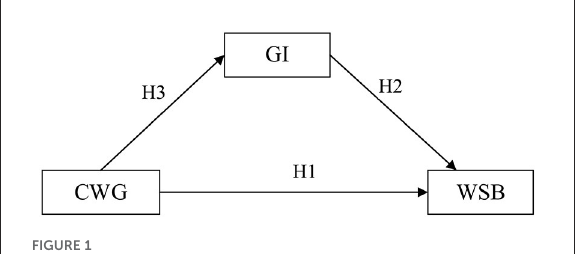
FIGURE1 The conceptual model of this